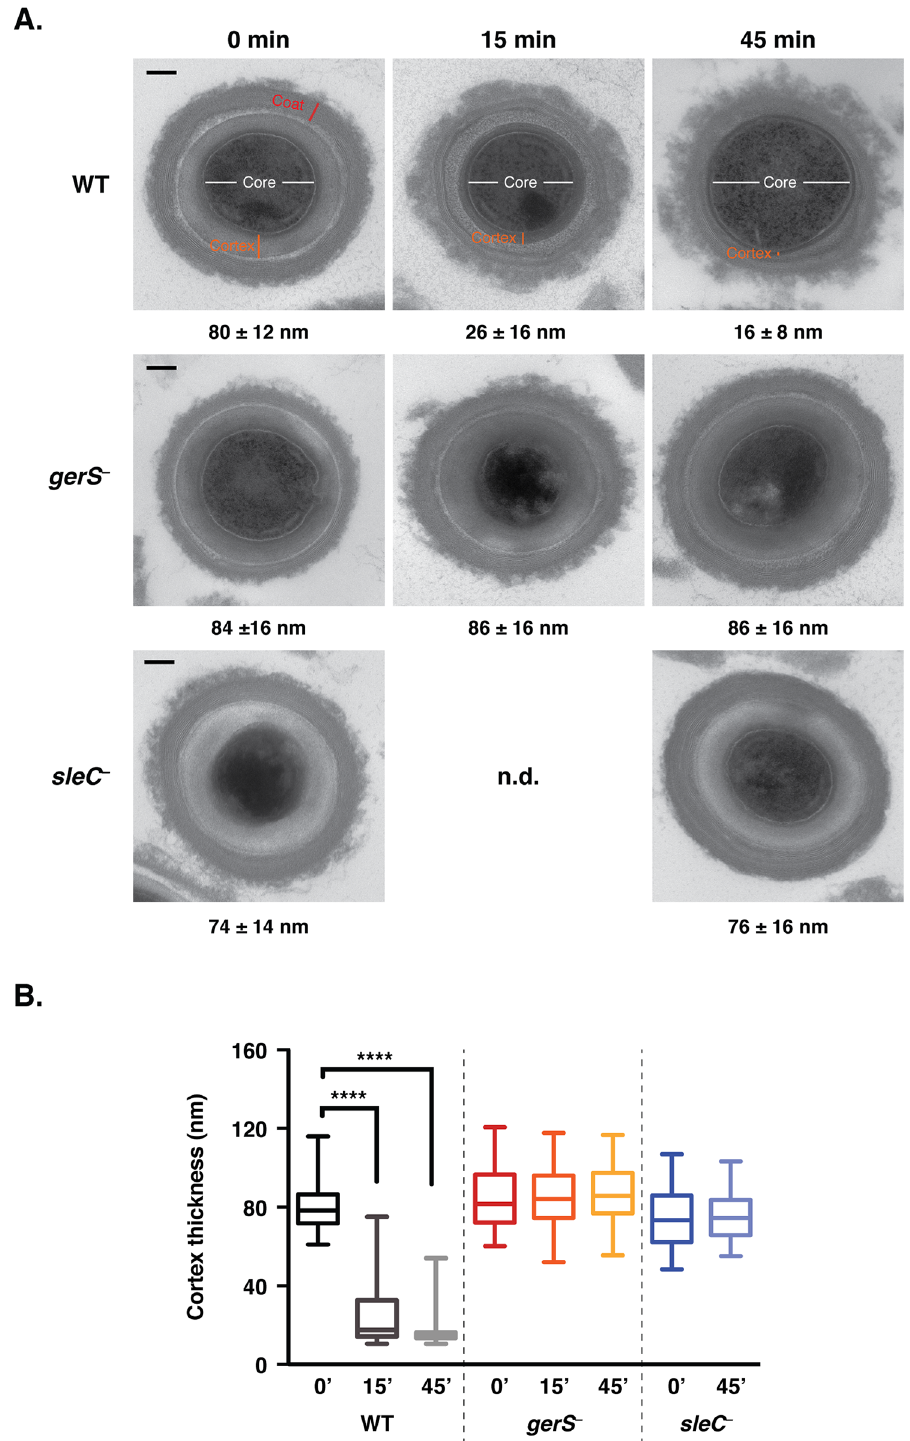
Fig 4. gerS − spores are defective in cortex hydrolysis. (A) TEM analyses of wildtype, gerS − and sleC −